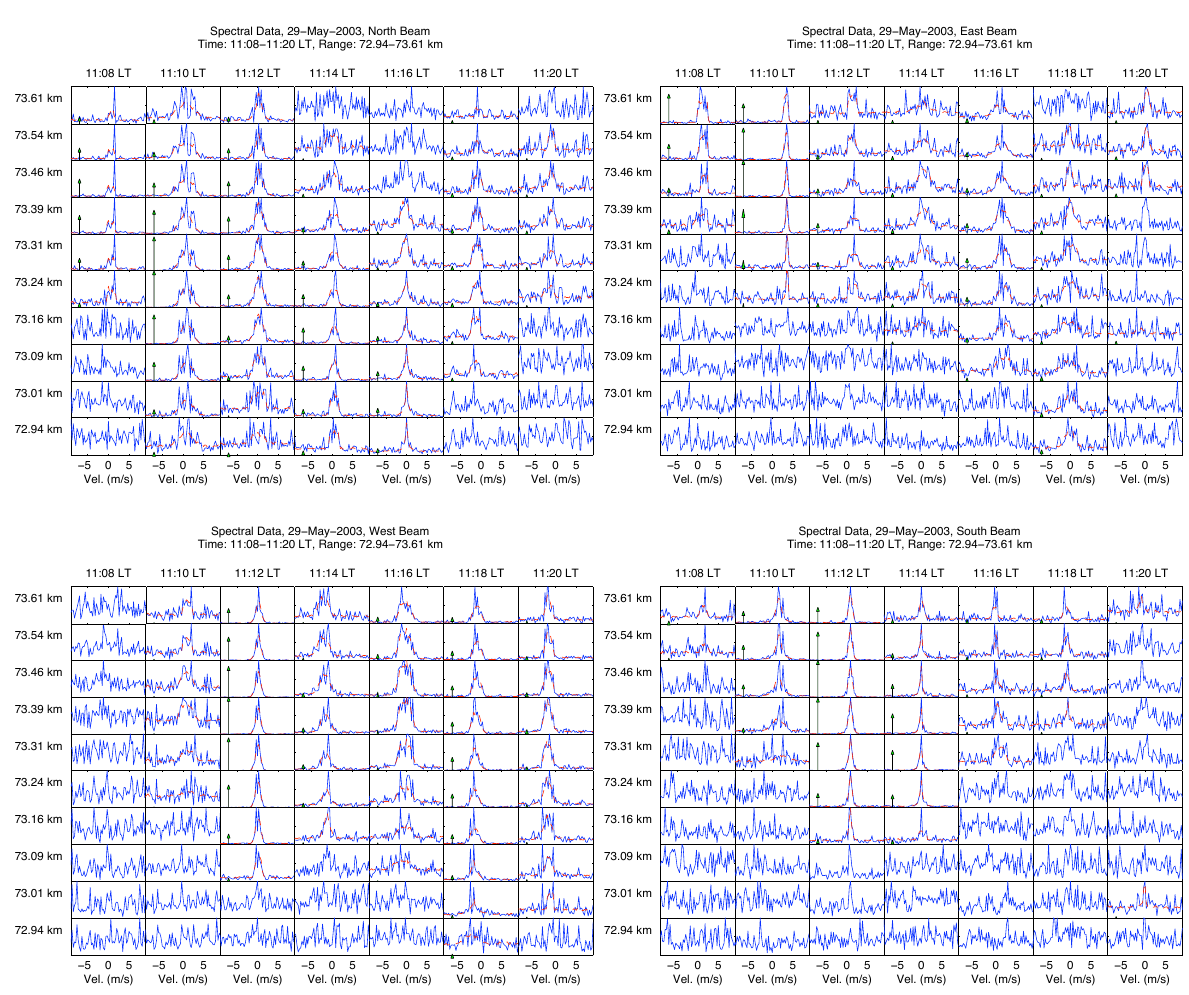
beams along with the corresponding correlation plots (on the top) and spectral width maps (on the bottom). Given the ing a minimum spectral width count of five. Also Figure 21 shows sample spectra from the same event in 2 min and 75